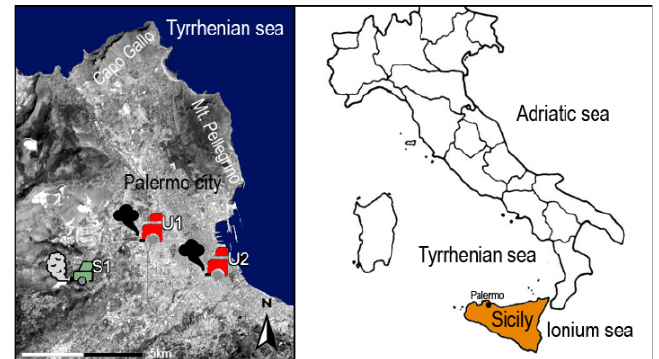
Figure 1. Location of the study area and sampling sites of air-monitoring stations.